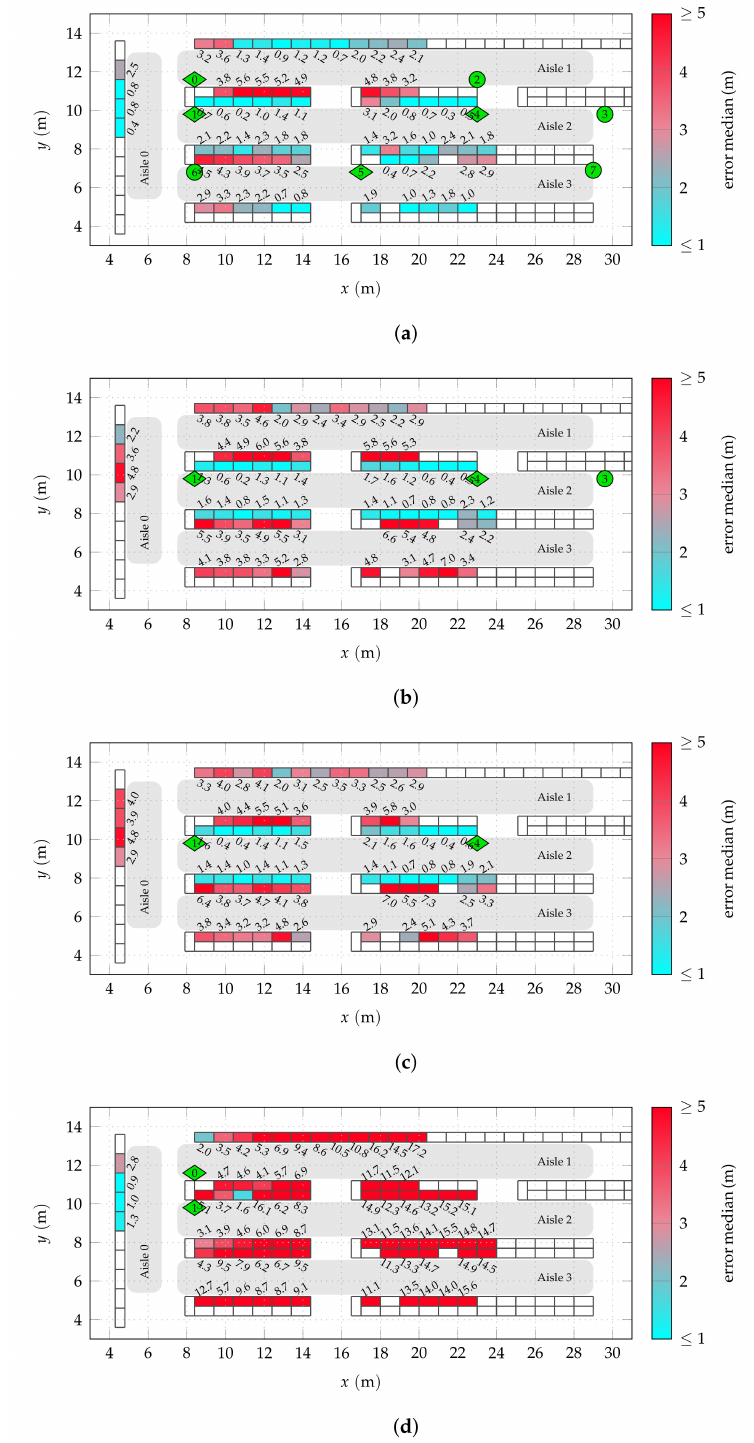
Figure 8. Shelf-wise median of the absolute positioning error for different anchor